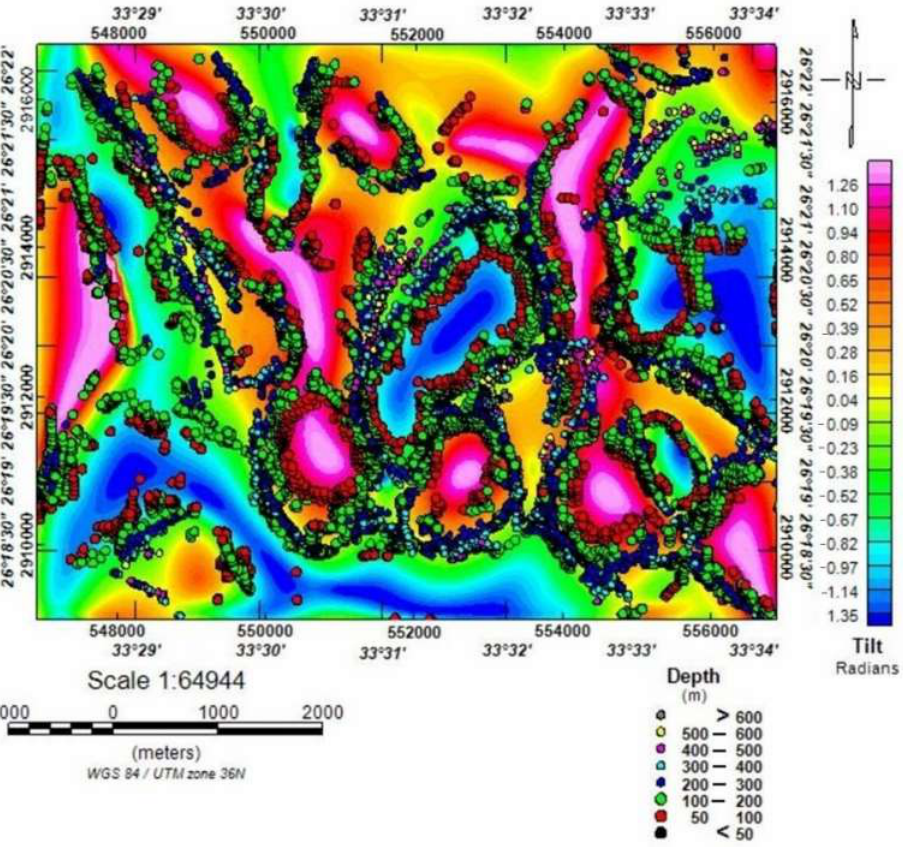
Figure 12. ED solutions map of the study area using SI = 0 obtained from RTP magnetic map. The solutions are superimposed on the zero contours of the TA